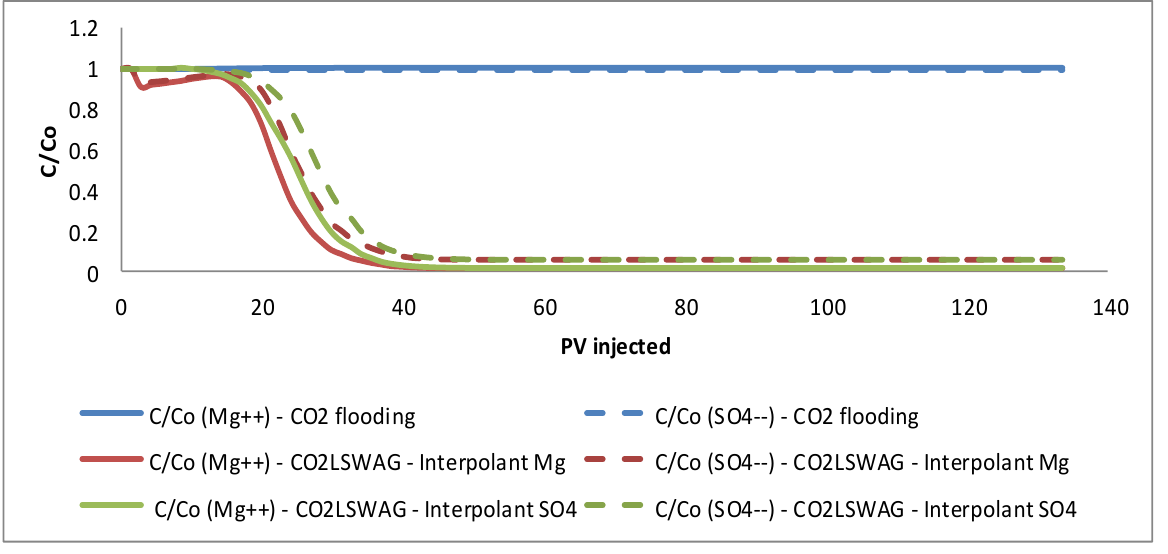
Figure 12. Results of pH and Mg 2+ and SO 42 − concentration in the effluent for continuous CO 2 injection and CO 2 -LSWAG considering Mg and SO 4 as ion